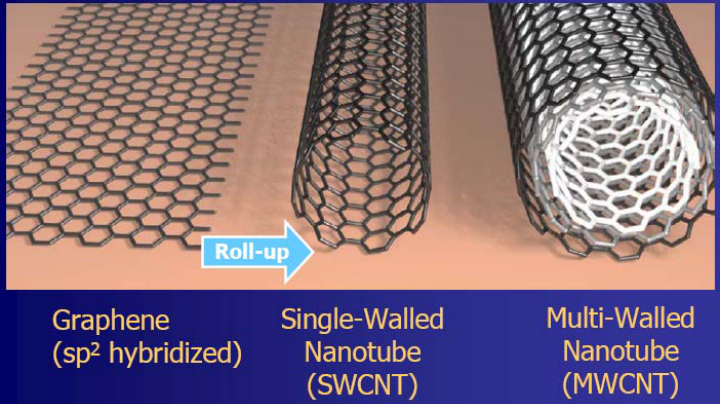
Figure 5. Schematic model describing single-walled and multi-walled carbon nanotubes conceptually obtained from single graphene sheets (courtesy of K. Banerjee/ California University, Santa